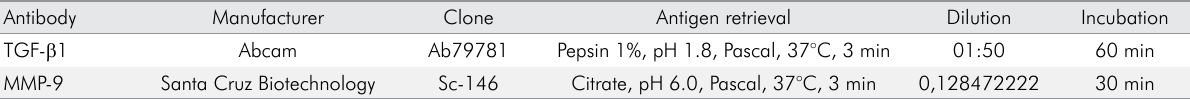
Table 1. Manufacturer, clone, antigen retrieval, dilution, and incubation period of the monoclonal primary antibodies.